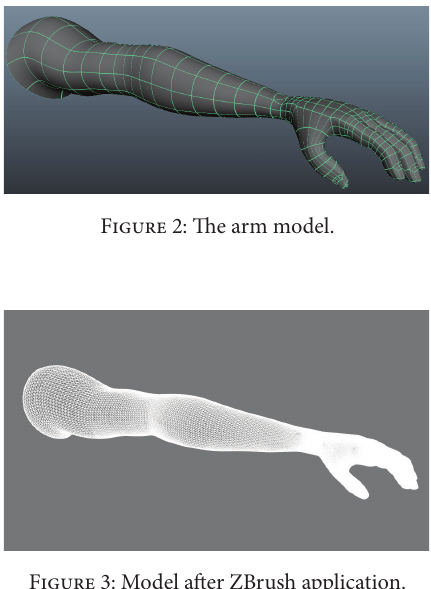
Figure 3: Model after ZBrush application.